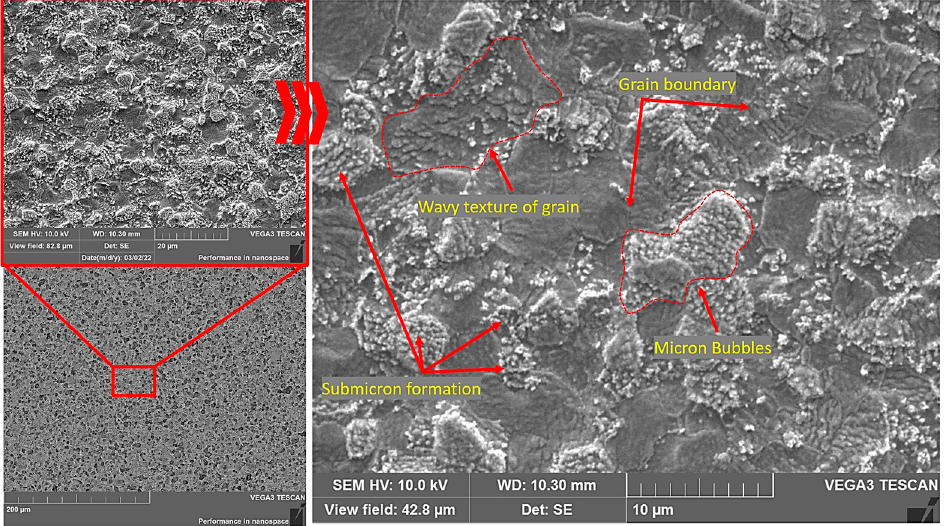
Figure 5. Microstructure of sample No. 1 surface after irradiation with helium plasma at ~905 °C.